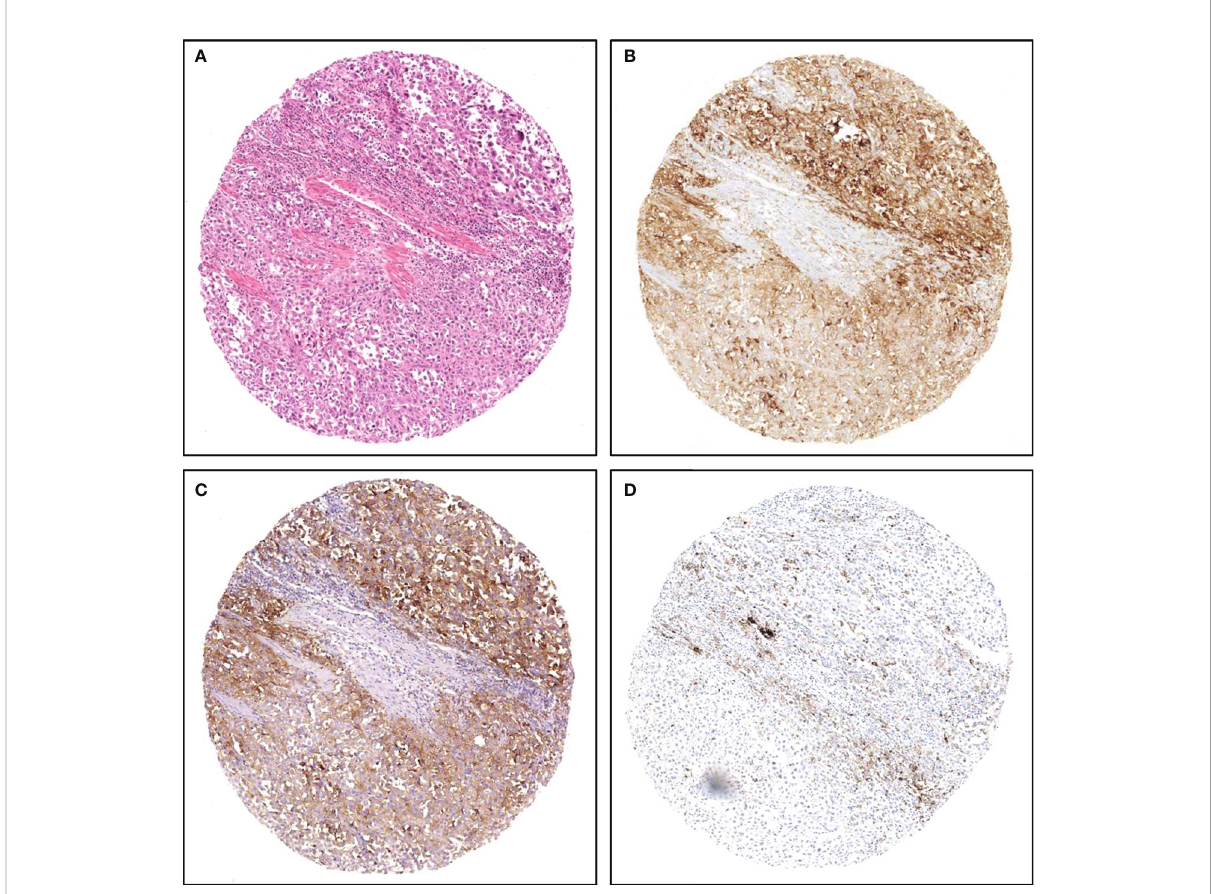
FIGURE 1 Representative images of PD-L1 staining on TMA cores from the same case. (A) hematoxylin and eosin; (B) SP263 assay; (C) 22C3 assay; (D) SP142